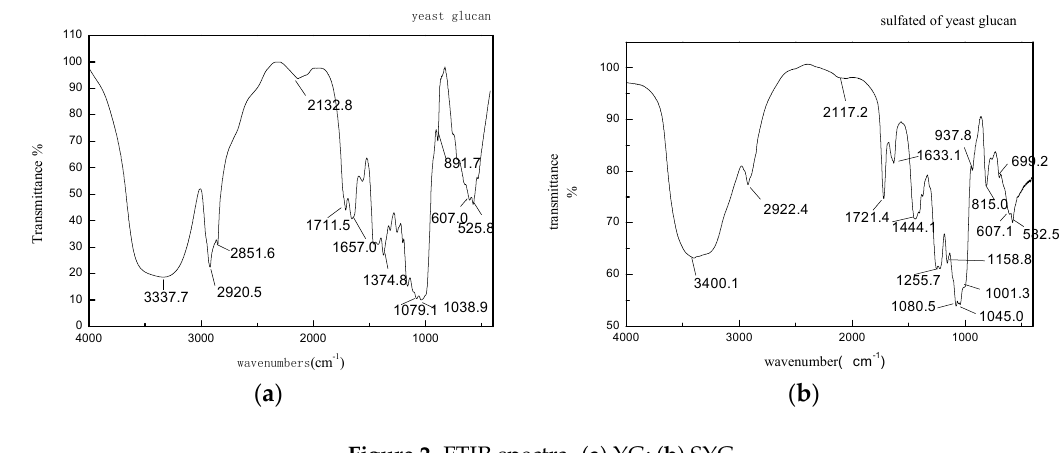
Figure 2. FTIR spectra. ( a ) YG; ( b ) SYG.